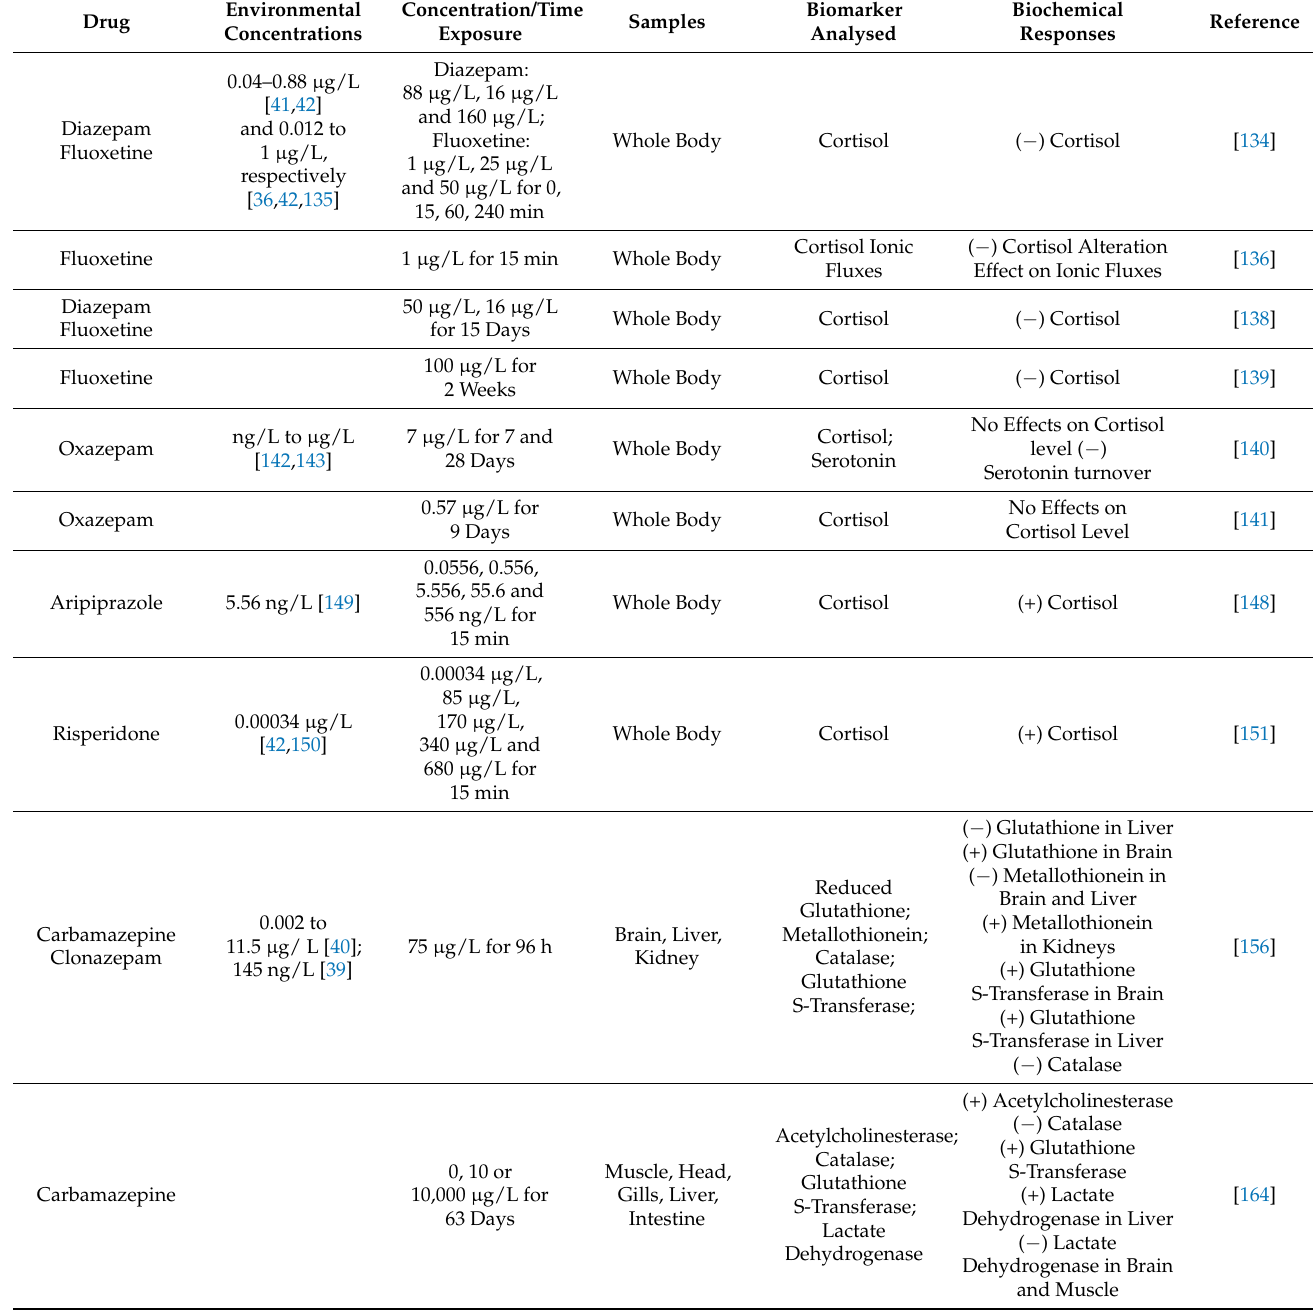
Table 2. Biochemical responses in zebrafish exposed to antiepileptic and antipsychotic drugs. Environmental Concentration/Time Biomarker Drug Samples Concentrations Exposure